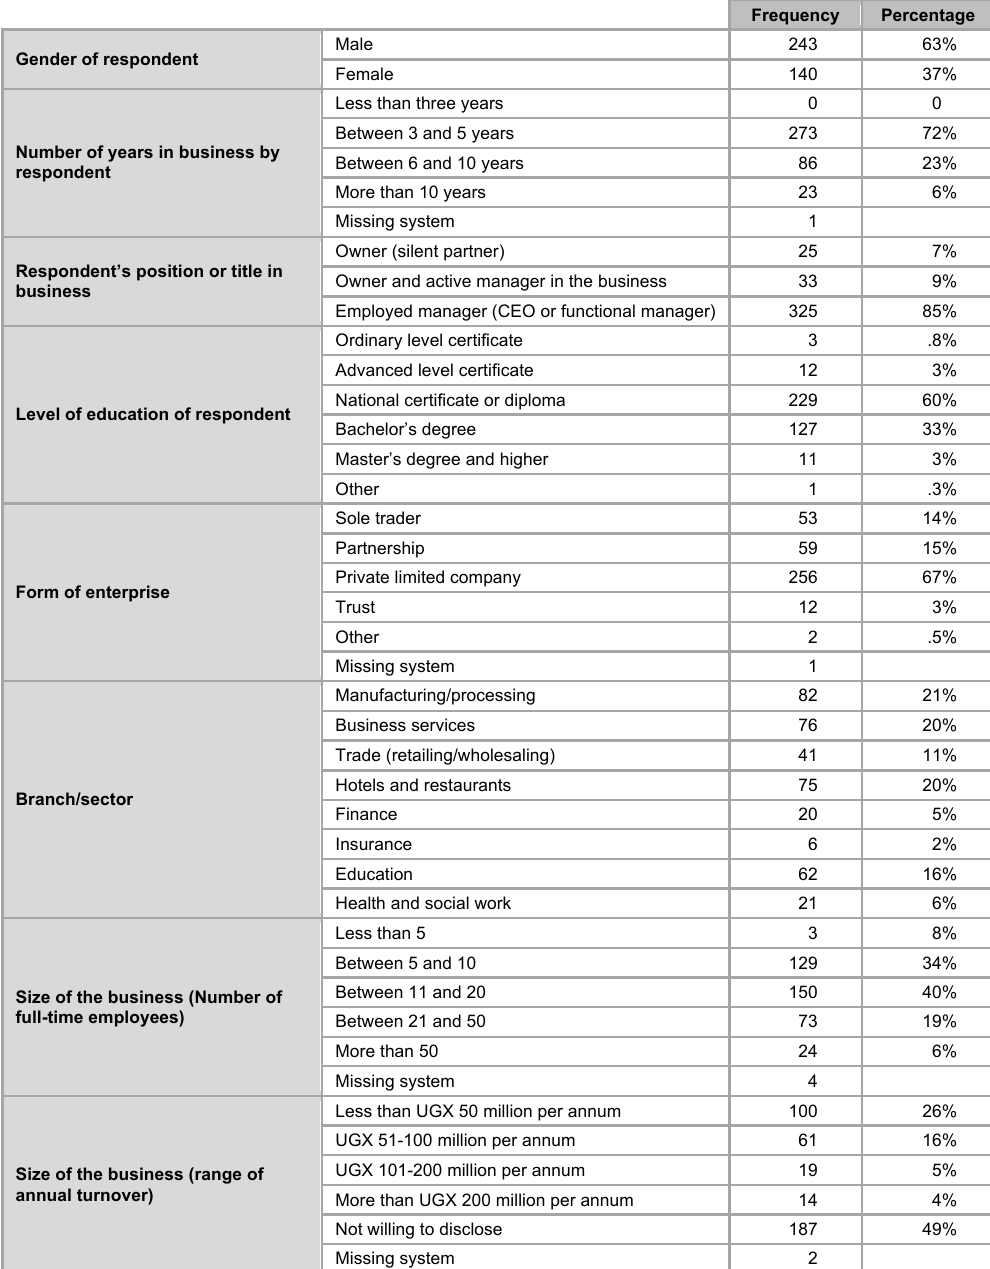
Demographical profile of